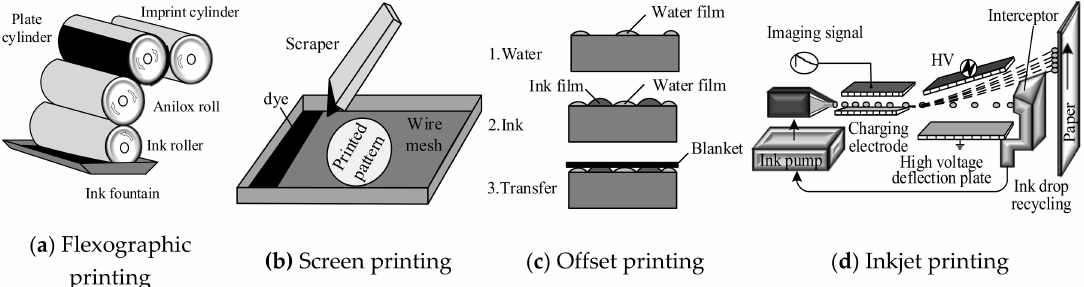
Figure 8. Four Typical Printing